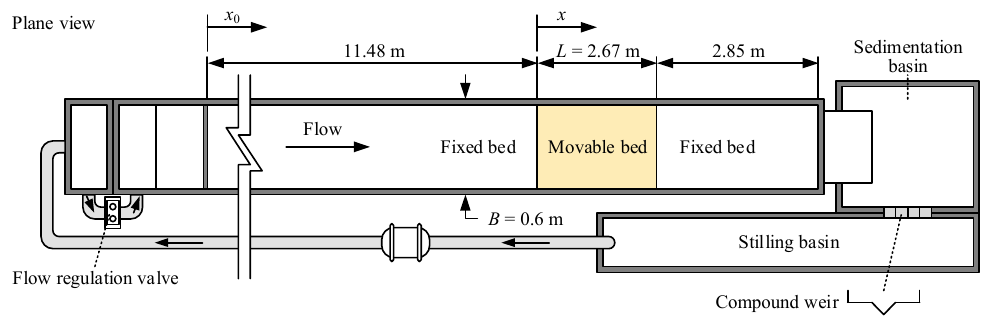
Figure 1. Plane view of the experimental channel (not to scale). Table 1. Summary of the experimental conditions.